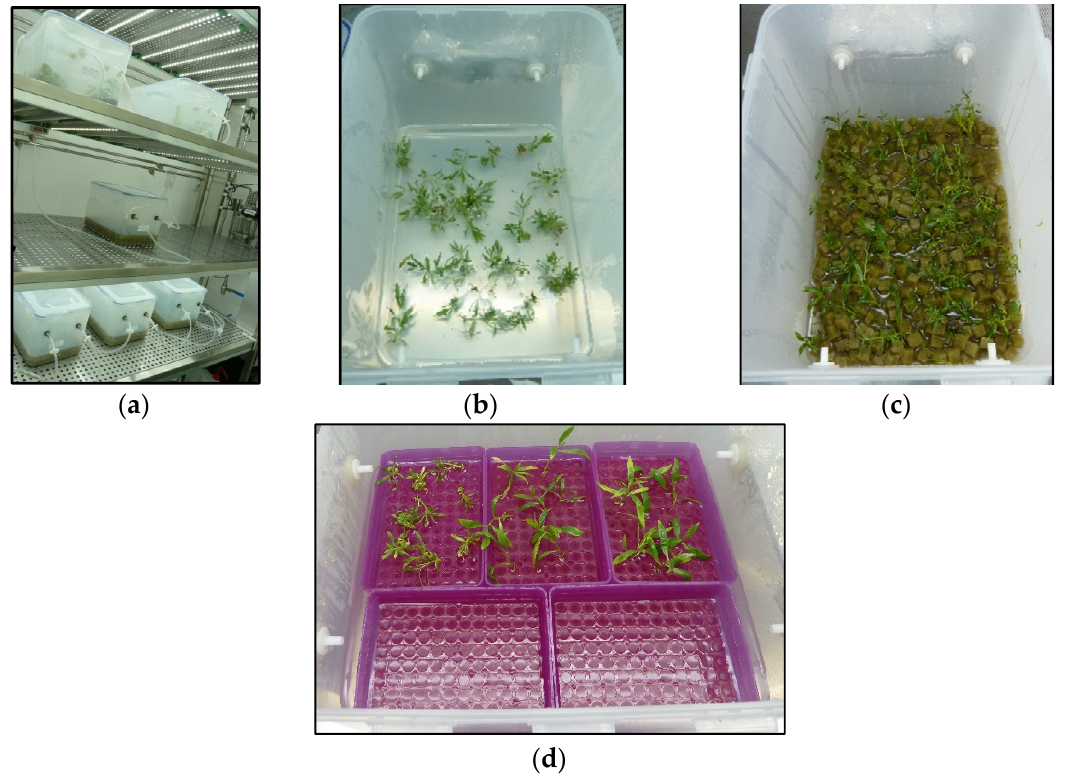
Figure 1. Willow explants micropropagated in continuous immersion bioreactors with different substrates. ( a ) Ten-liter bioreactors used for proliferation. ( b ) Explants cultured without support. ( c ) Explants inserted between 1 cm 3 rockwool cubes. ( d ) Explants placed on plastic boxes with holes.